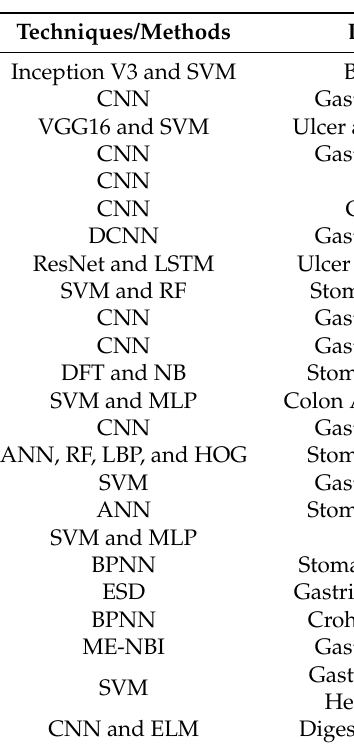
Table 1. Existing studies on stomach disease detection and